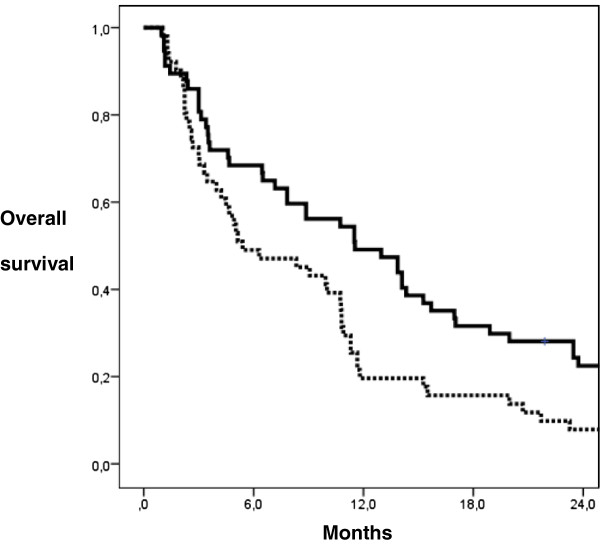
Actuarial OS probability according to GTV calculated by Kaplan-Meier (log-rank test; p< 0.019). GTV < 2 ccm (m=57): continuous line, GTV ≥ 2 ccm (m=51): dotted line.